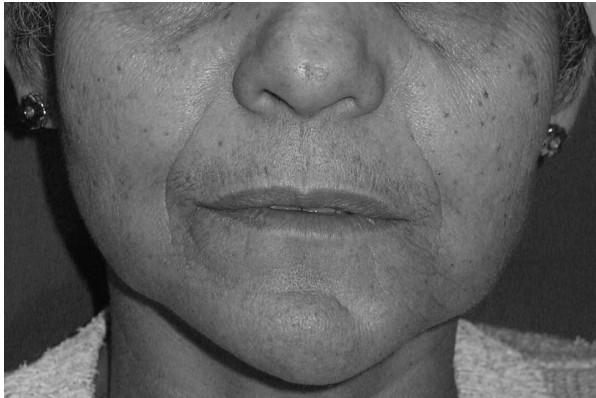
Figure 8 - Ten-year postoperative aspect showing preserved mandible con- tour and clear chin form without any enlargement. There were no sensitive or motor nerve impairment